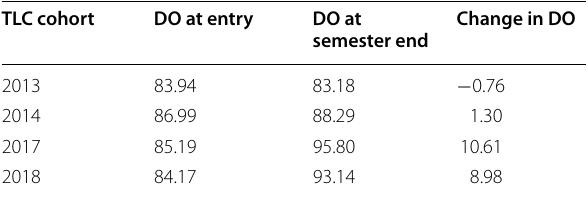
Table 4 Group developmental orientation (DO) at entry and semester’s end